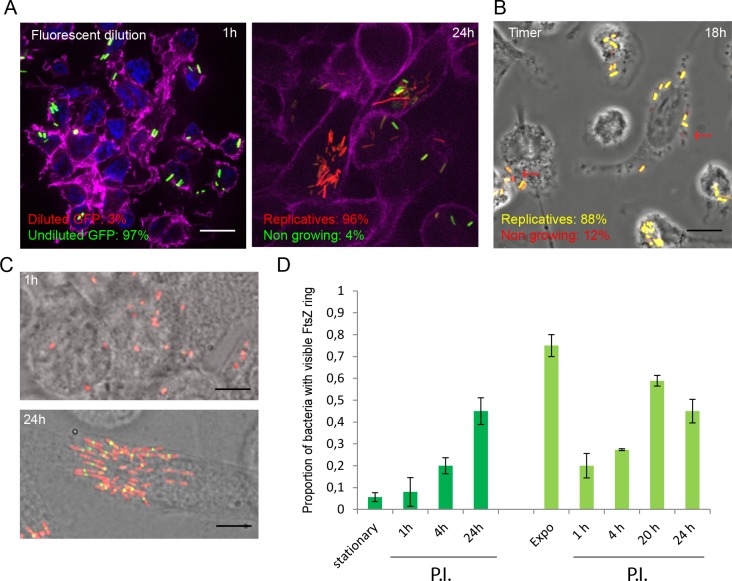
Non-growers LF82 are produced during intracellular growth.A) Representative image of LF82 containing the fluorescent dilution plasmid (pFC6Gi) at 1 h and 24 h post-infection. The frequency of replicative and non-growing LF82 (undiluted GFP) is indicated (N = 300). B) Representative image of LF82 containing the TIMER plasmid (pSC101-TIMER) at 18 h post-infection. The red arrows points toward the reddest LF82. The frequency of replicative and non-growing LF82 is indicated (N = 300). C) Representative images of LF82-mCherry FtsZ-GFP at 1 h and 24 h post-infection. Infections presented in panels A to C were performed with a stationary phase culture of LF82 (O.D. 2). Scale bars are 5 μm. D) Measure of the frequency of LF82 presenting a FtsZ ring in populations growing in LB or within macrophages (N = 300).